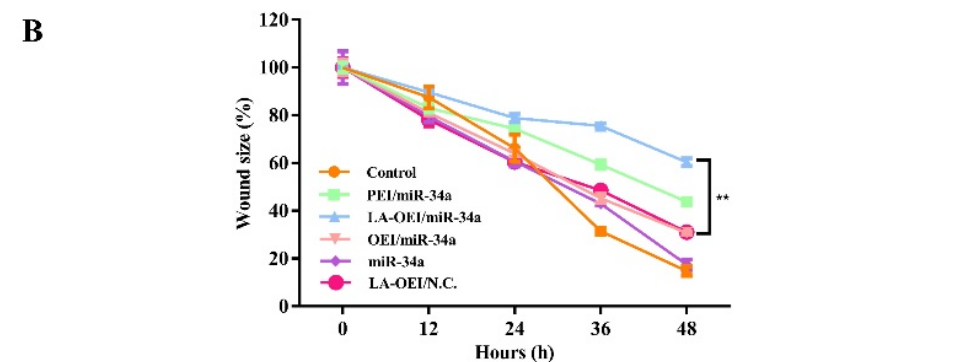
Figure 8. The anti-migration effect of HeLa cells after the miR-34a using wound healing assay. ( A ) the scratch observation of HeLa cells after the treatment with different nanoparticles. The scale bar is 200 µ m. ( B ) Quantitative analysis of wound size, in which data were presented as the mean value ± SD of triplicate experiments (** p < 0.01).